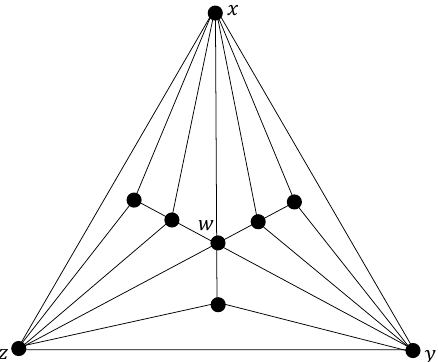
Figure 5: A triangulation G on the sphere with guard( G ) = 3 and j V ( G ) j = 9 whose the minimum guarding set induces a copy of K